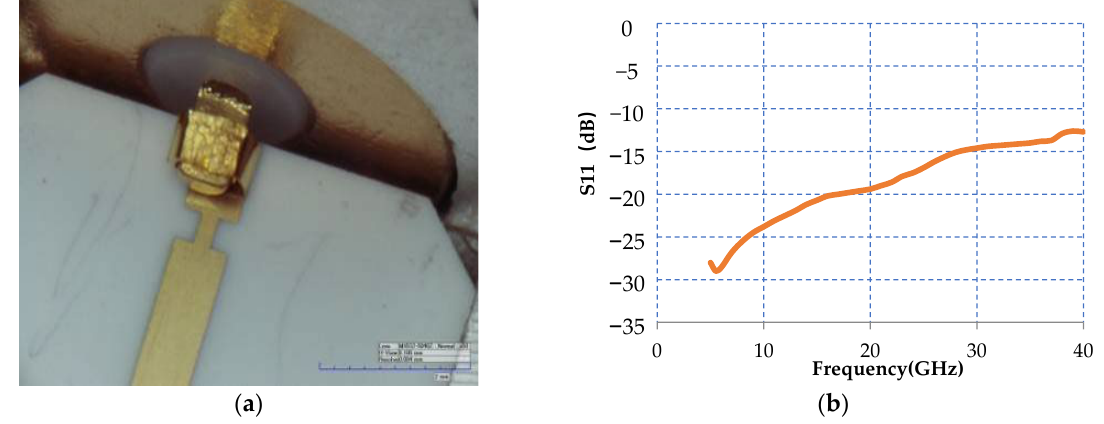
Figure 8. The photo and test results of the gold-ribbon wrap bonding with improvement. ( a ) Photo of the wrap bonding with improvement; ( b ) Reflection loss of the wrap bonding with improvement.